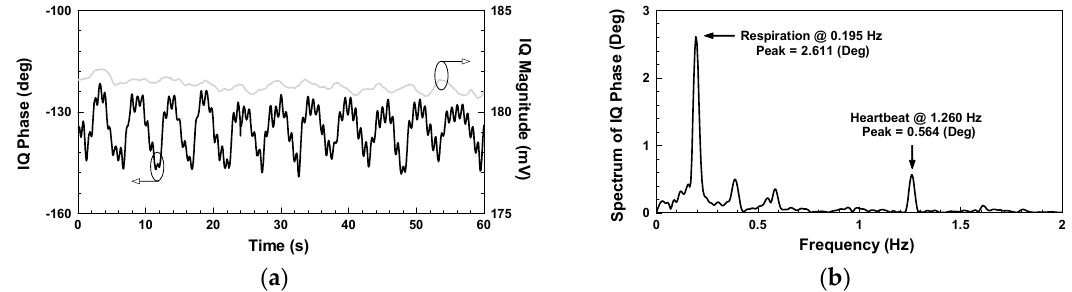
Figure 5. Vital sign detection results using the conventional CW radar: ( a ) IQ magnitude and phase; ( b ) Spectrum of IQ phase in Figure 5a.